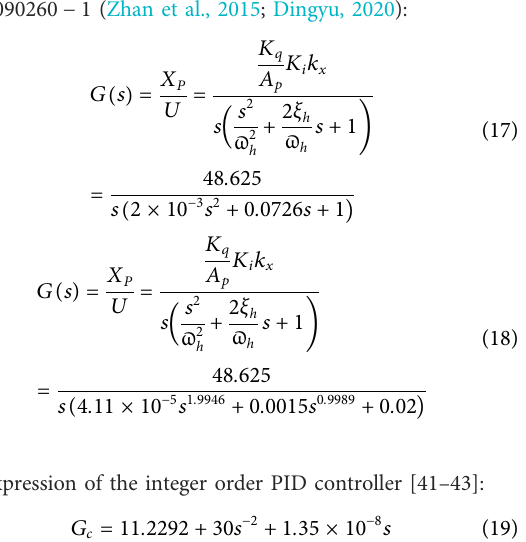
FIGURE 13 | algorithm for FOPID controller - integer order parameter setting diagram of controlled objects; (B) Parameter tuningdiagramofFOPIDcontroller-fractionalcontrolledobjectby intelligent control algorithm; (C) Intelligent control algorithm PID controller - fractional integer order controlled object parameter setting diagram; (D) The intelligent control algorithm for FOPID controller - fractional integer order parameter setting graph of controlled